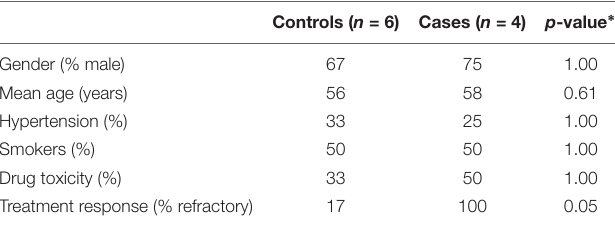
TABLE 1 | Demographic and clinical features of the study